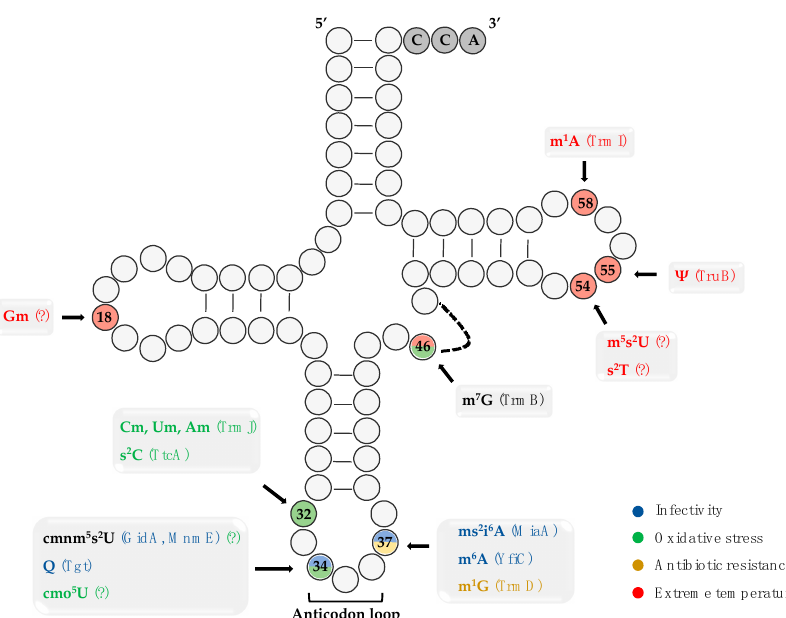
Figure 1. Schematic representation of the tRNA secondary structure and the post-transcriptional modifications that affect the bacterial infectivity and stress adaptability. Blue indicates modifications that affect bacterial virulence, yellow modifications that provide antibiotic resistance, green and red modifications are associated with bacterial adaptation under oxidative stress and extreme temperatures, respectively. Black corresponds to dual-functional modifications. The “writer” enzymes are included in parenthesis.